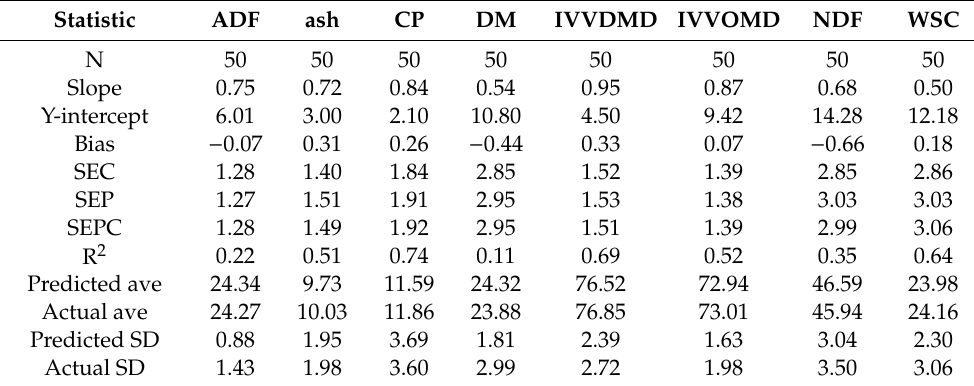
Table 3. Statistics from comparing results predicted with the above-mentioned models compared to lab results of 50 independent samples. This includes the slope of the regression line, the y-intercept, the bias, standard error of covariance (SEC), standard error of prediction (SEP) and standard error of prediction covariance (SEPC), the coe ffi cient of determination (R 2 ), the predicted and actual average, and the predicted and actual standard deviation (SD).